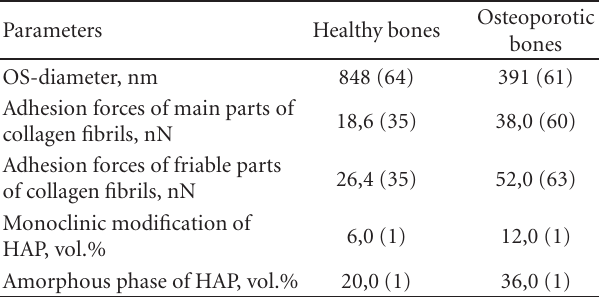
Table 1: The structural and adhesion parameters of the healthy and osteoporotic bones.